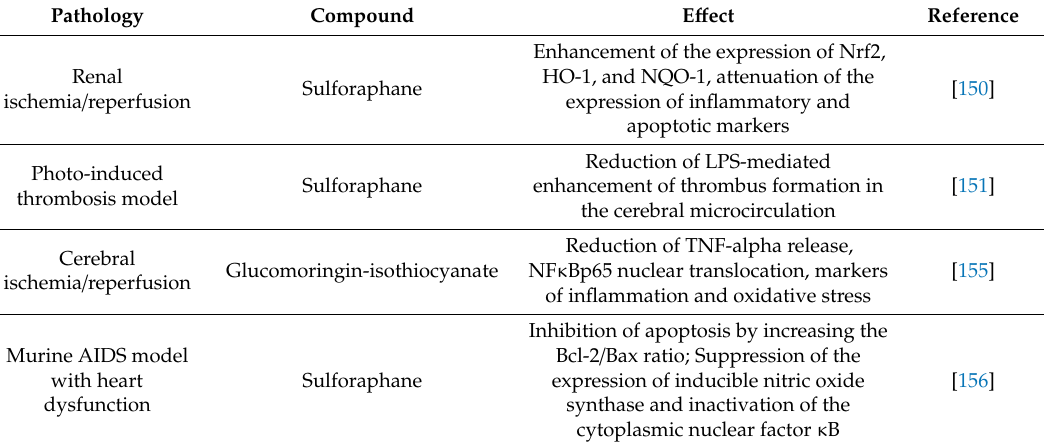
Table 3. The most common and studied isothiocyanates that provide mitochondrial